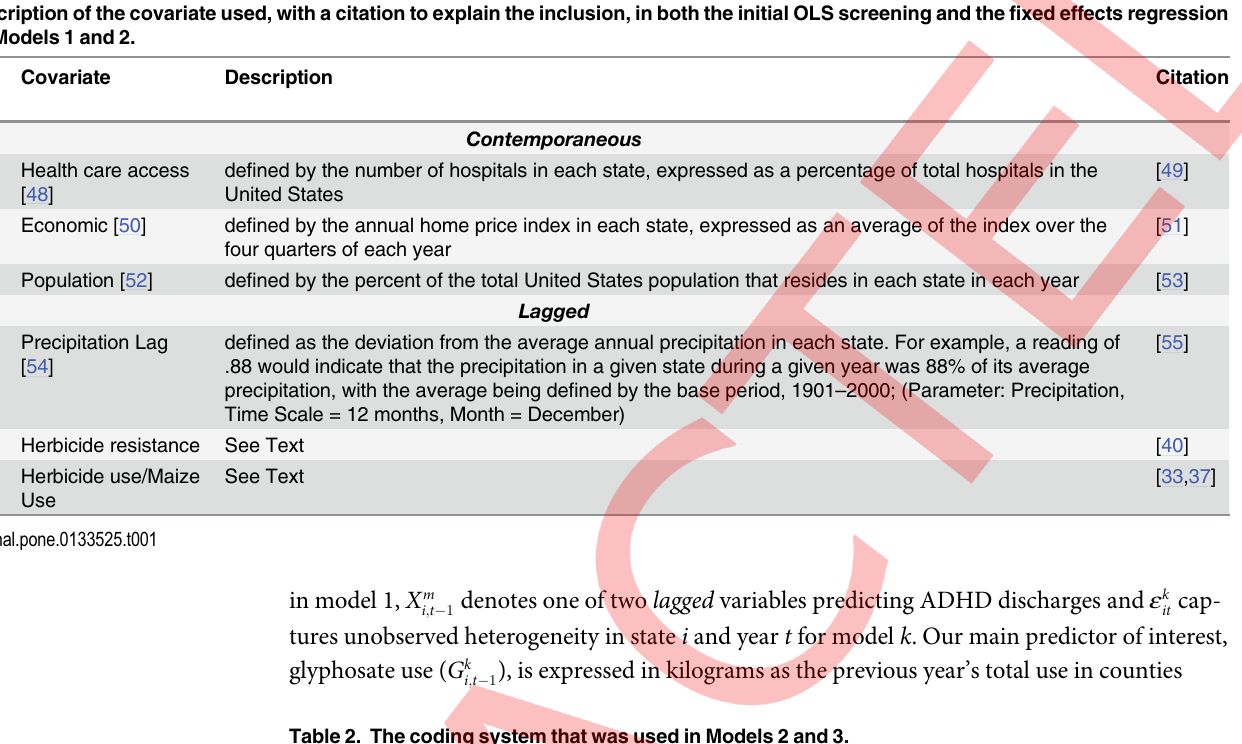
Table 2. The coding system that was used in Models 2 and